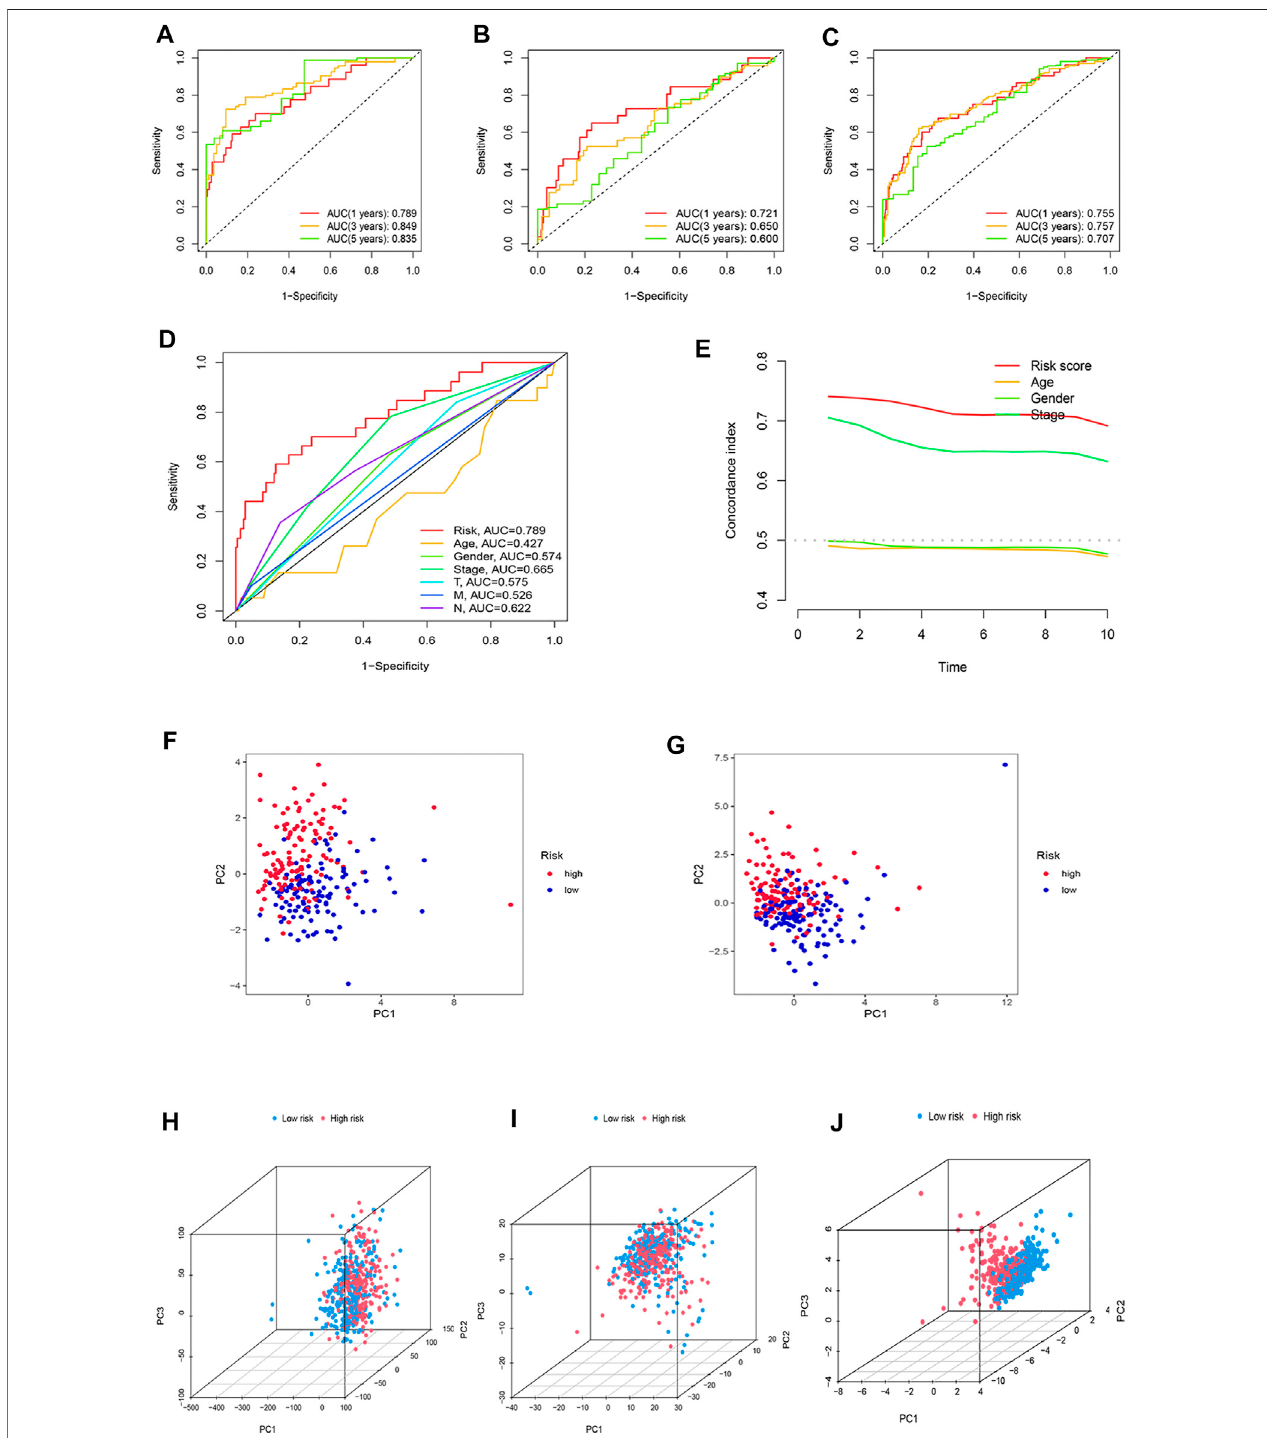
FIGURE6| Assessmentofthepredictiveriskmodelandprincipalcomponentanalysis.The1-,3-,and5-yearROCcurvesofthe (A) trainingset, (B) testingset,and (C) entireset. (D) ROCcurvesoftheclinicalcharacteristicsandriskscore. (E) Concordanceindexesoftheriskscoreandclinicalfeatures. (F) PCAbetweenhigh-riskand low-risk groups based on 16 prognostic lncRNAs in the training set (G) and testing set. (H) PCA between the high-risk and low-risk groups based on entire gene expression pro fi les, (I) alloxidative stressgenes, (J) andriskmodelbasedontherepresentation pro fi lesofthe16oxidativestress-related lncRNAsintheentireset.